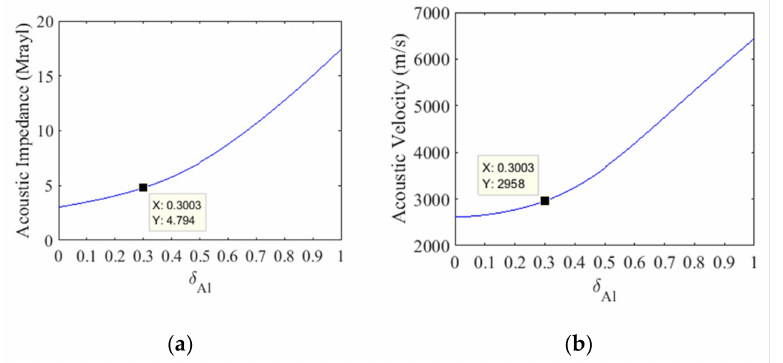
Figure 5. ( a ) Theoretical curves of the acoustic impedance and ( b ) the propagation velocity were used to determine the alumina volume fraction and the matching layer